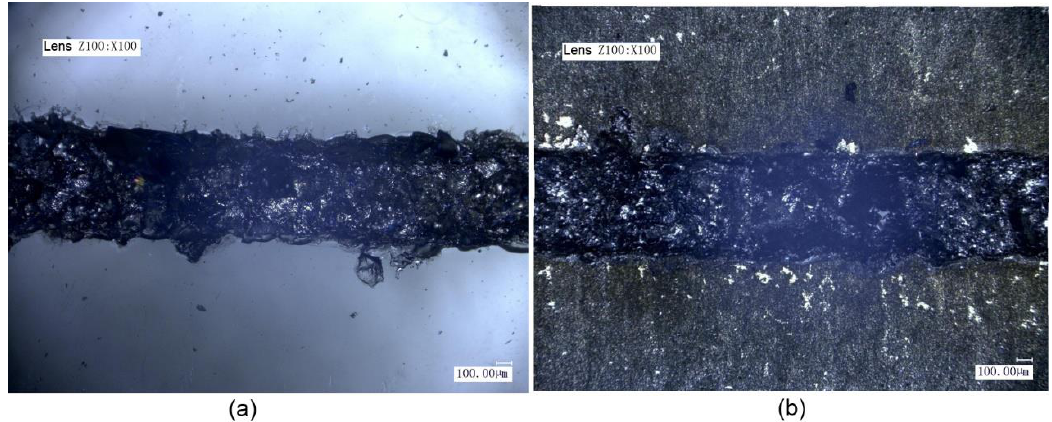
Figure 7. Micrographs of titanium alloy and high borosilicate glass using laser voltage for transmission welding of 460 V: ( a ) glass and ( b ) titanium alloy.